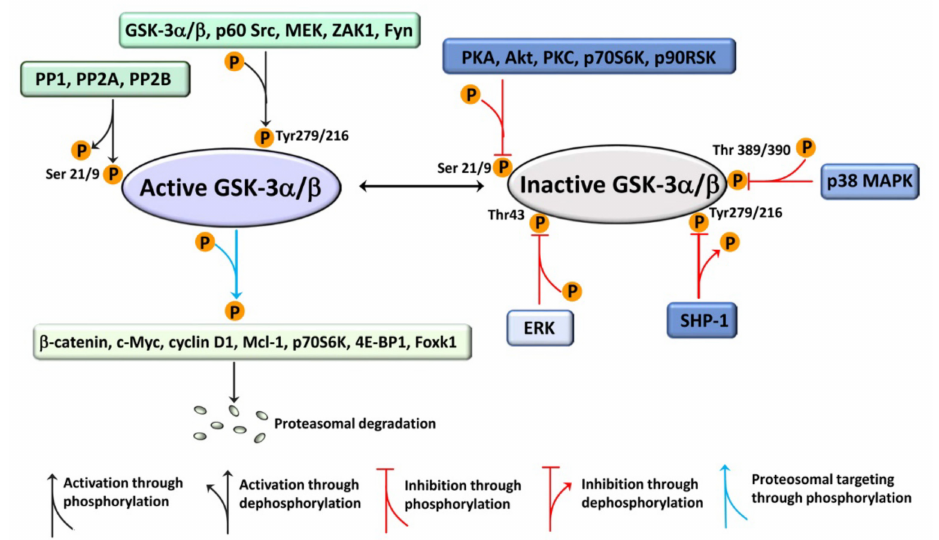
Figure 2. Overview of GSK-3 isoform activation control and downstream signaling. In resting cells, GSK-3 isoforms are constitutively active, i.e., phosphorylated on Tyr 279/216 residues. These residues are targeted by GSK-3 itself as well as by other kinases (p60 Src, MEK, ZAK1, Fyn). Phosphotyrosines are dephosphorylated by the protein phosphatase SHP-1. Upon a variety of external cues, phosphory- lation on Ser21 (GSK-3 α ) or Ser9 (GSK-3 β ) downregulates the enzymatic activity. Serine residues are targeted by a variety of upstream kinases (PKA, Akt, PKC, p70S6K, and p90RSK). Phosphorylation on Ser 21/9 residues is facilitated by phosphorylation on Thr43 by ERK and on Thr 389/390 by p38 MAPK. The protein phosphatases PP1, PP2A, and PP2B dephosphorylate the serine residues, thereby activating GSK-3 paralogs. Active GSK-3 isoforms phosphorylate a broad range of substrates ( β -catenin, c-Myc, cyclin D1, Mcl-1, p70S6K, 4E-BP1, Foxk1, etc.) which are then proteolytically degraded via the